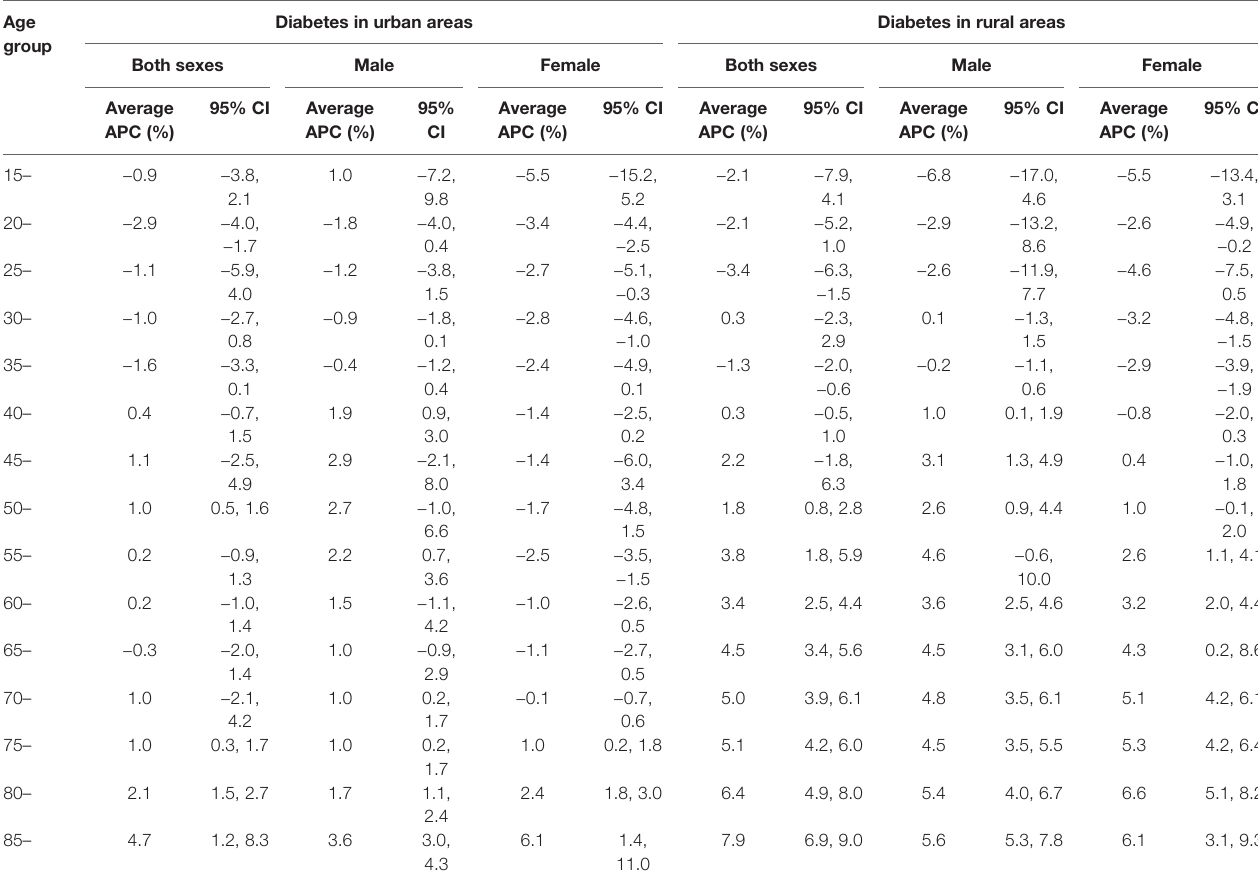
TABLE 2 | Annual percent changes (APCs) in age-speci fi c mortality rates of diabetes in urban and rural areas. Age Diabetes in urban areas Diabetes in rural group